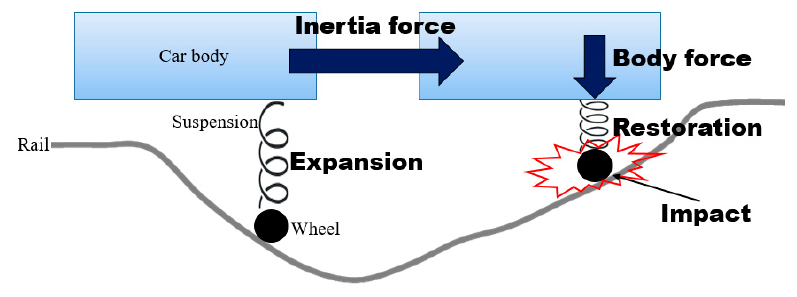
Figure 10. Impact load diagram in field measurements.